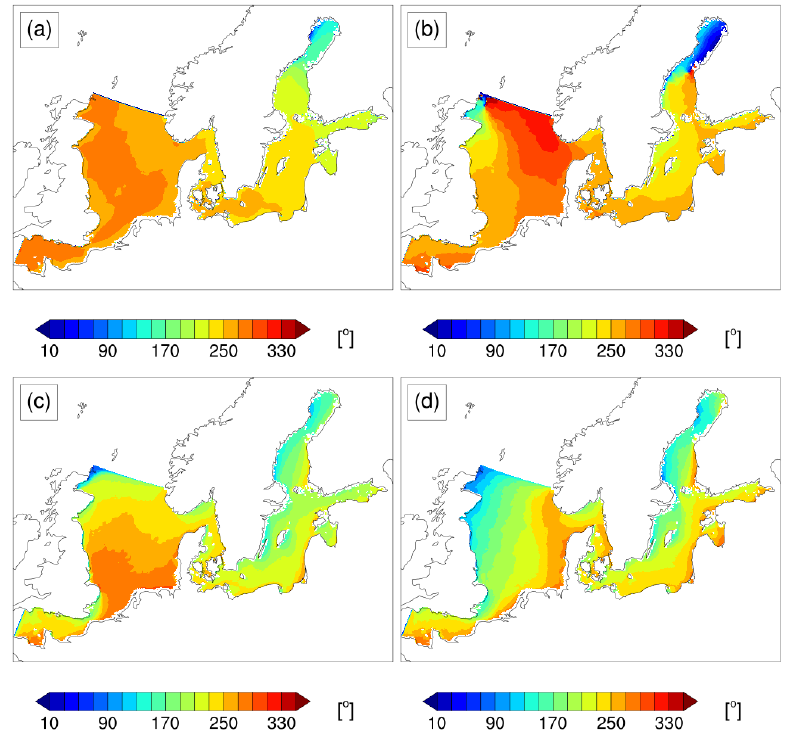
Figure 7. The mean wind direction (the top row) and wave direction (the bottom row). Column 1 ( a , c ) represents the results from Exp1 in January and July in column 2 ( b , d ). All the direction is the direction from which it originates (unit: ◦